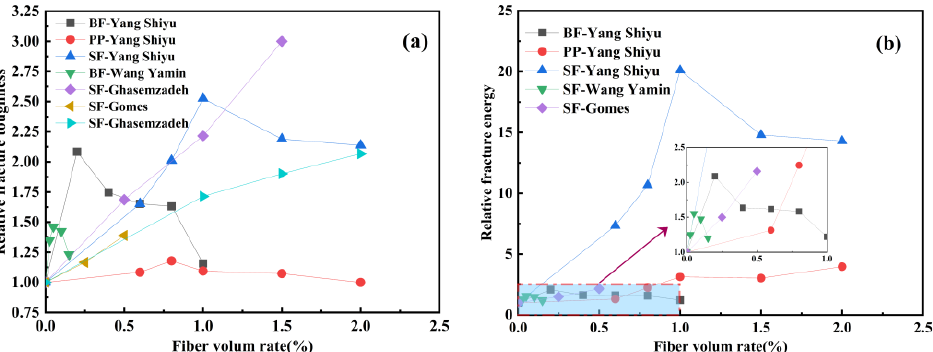
Figure 26. The effect of fiber volume rate on fracture properties of common geopolymer concrete: ( a ) Relative fracture toughness; ( b ) relative fracture energy.